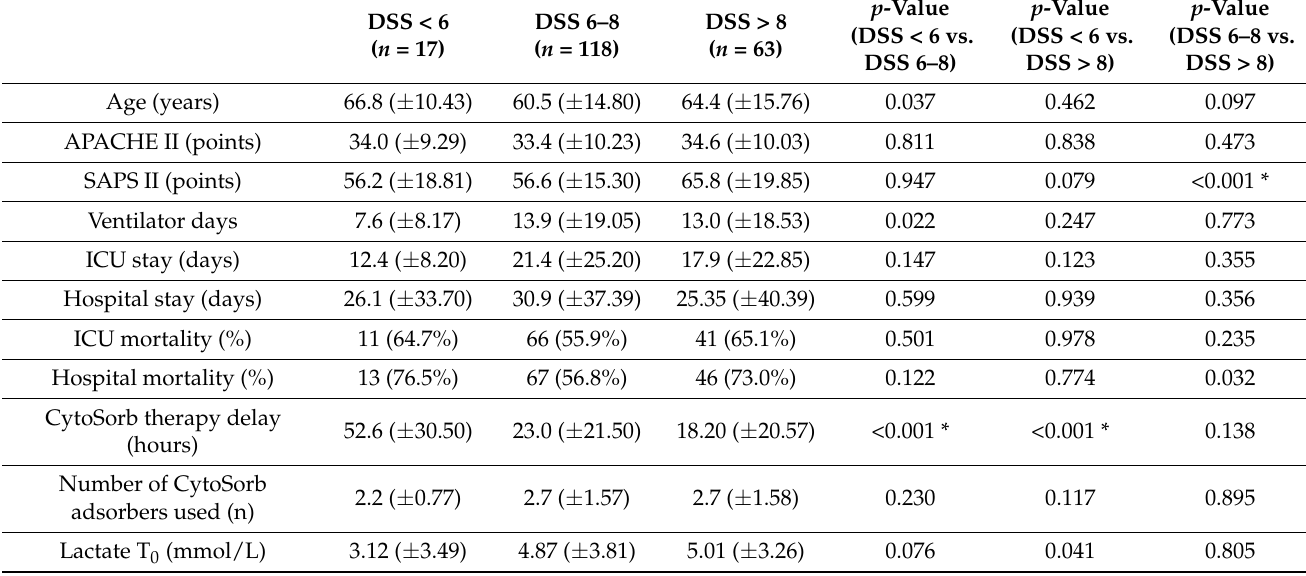
Figure 3. Kaplan–Meyer survival analysis at day 7 of the entire patient cohort. The p = value is via log-rank test. * = Statistically significant using Bonferroni-adjusted alpha critical value = 0.017 for groups <6 vs. >8, but no other comparisons. A total of 198 patients were treated with CRRT and CytoSorb, 61.1% of whom were male. The diagnoses in this study population included pneumonia ( n = 76, 38.3%), abdomi- nal sepsis ( n = 85, 42.9%), urosepsis ( n = 13, 6.5%) and miscellaneous ( n = 24, 12.1%). The baseline characteristics are depicted in Table 2. With regard to gender, the APACHE 2 Score and ICU and hospital days as well as ICU-mortality, there were no differences between the groups. Significant differences were found in age, SAPS 2, ventilation days, hospital mortality and time delay until start of therapy, all of which scored items without T 0 lactate and points in the dynamic scoring system (Table 2). Table 2. Baseline characteristics, DSS relevant parameters and outcome variables depending on score groups in the CytoSorb group. Presented are mean values ± standard deviations, frequency and percent (%) and levels of